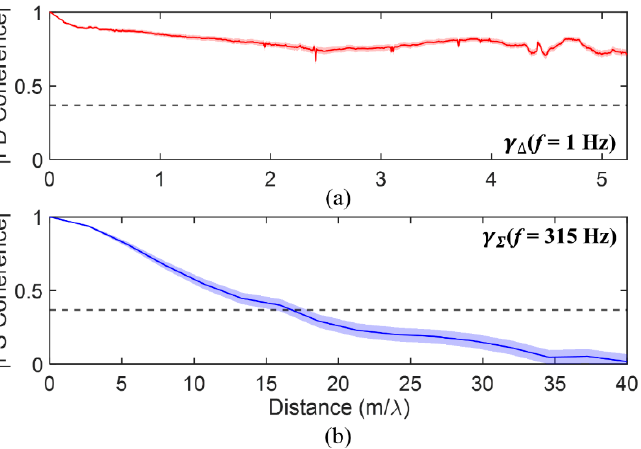
Figure 6. Coherence vs. distance (normalized by wavelength) comparison for frequencies within the signal bandwidth and obtainable by either the frequency-difference or frequency-sum autoproduct. Results for the genuine in-band field are shown in black, results for the frequency-difference auto- product are shown in red, and results for the frequency-sum autoproduct are shown in blue. The horizontal dotted black line is the e − 1 threshold value for coherence length. Confidence intervals determined from (10) and (11) are indicated as semitransparent regions, and the frequency is displayed in the upper right of each panel for 19 Hz ( a ) and 191 Hz ( b ).